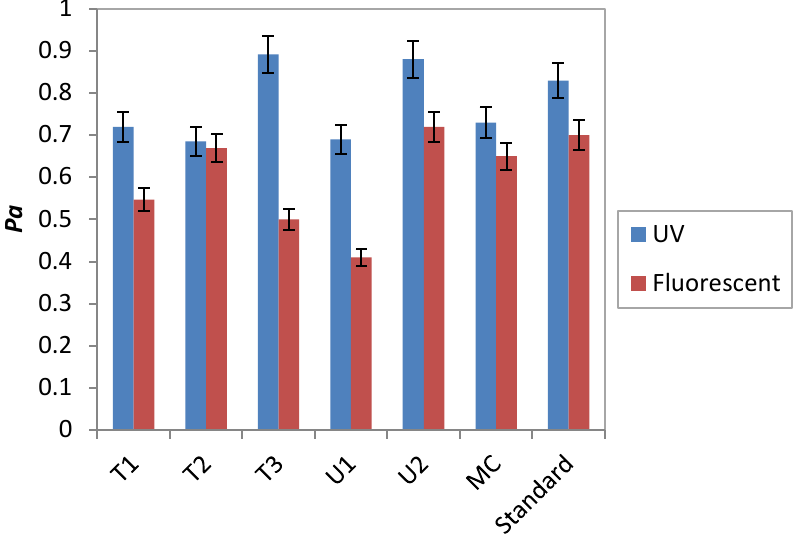
Figure 3. Photocatalytic activity of the as-deposited coatings and comparison with a commercially available photocatalytic surface (Pilkington Activ  ).